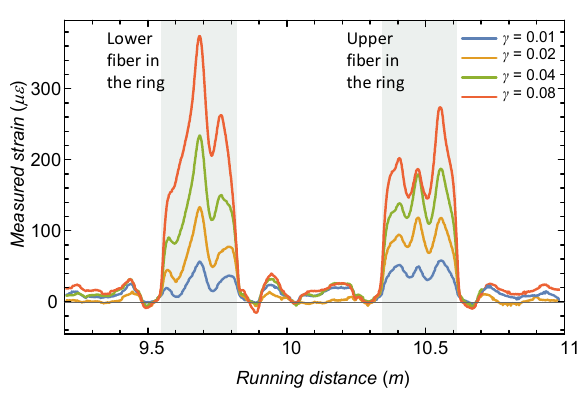
Figure 7. Conventional output from DSS tests.